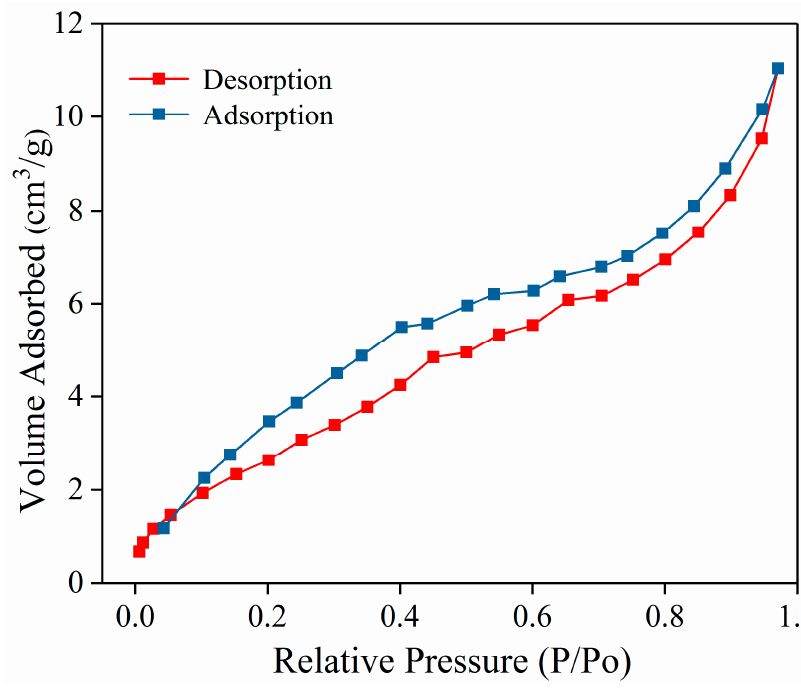
Figure 3. N 2 adsorption/desorption isotherms of the PDAMs.